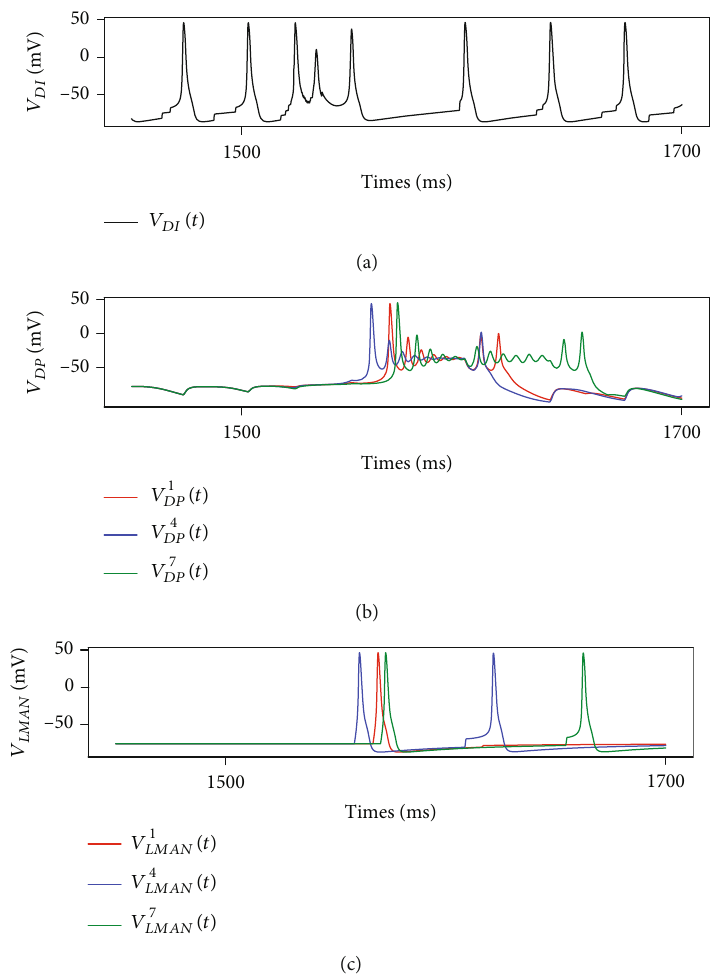
Figure 8: Membrane voltages of neurons in DLM and LMAN. Before the song, DLM (b) and LMAN neurons (c) are in the polarization state. At 1.5 s, the fi rst HVC neurons do not fi re until 1.57 s. Besides, LMAN neurons process the input from DLM